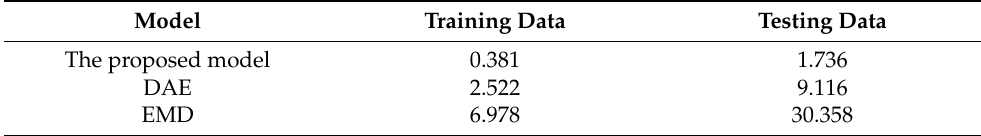
Table 14. Step value variance between noise reduction data and original